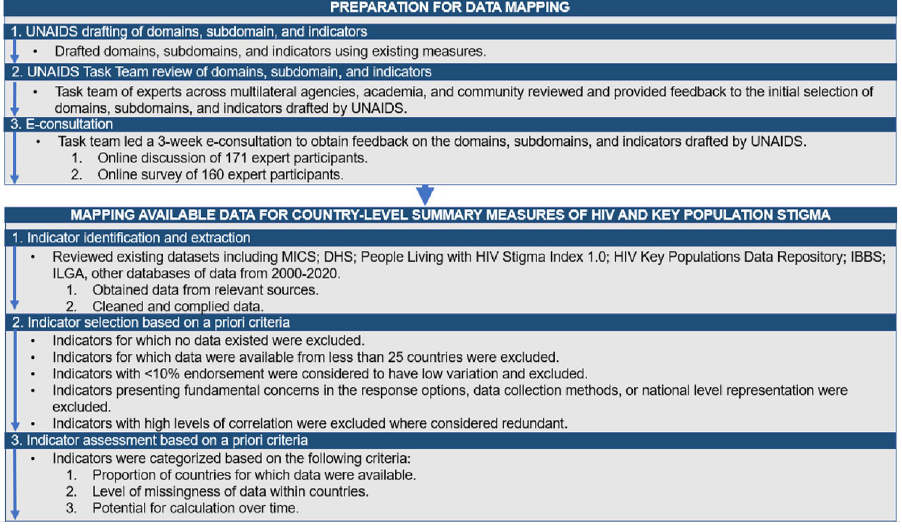
Fig 1. Flowchart of methodological approach for data preparation and data mapping. D AU : AnabbreviationlisthasbeencompiledforthoseusedthroughoutFigs 1 : Pleaseverifythatallentriesarecorrect : HS, Demographic and Health Surveys; IBBS, Integrated Biological and Behavioral Surveys; ILGA, International Lesbian, Gay, Bisexual, Trans and Intersex Association; MICS, Multiple Indicator Cluster